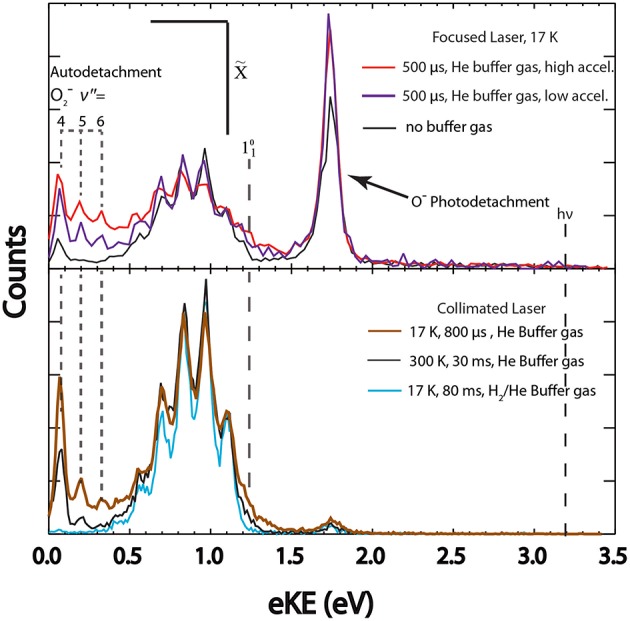
The total photoelectron spectrum for O3- with different temperatures, trap times, and laser configurations is shown. Top panel (high laser fluence): Spectra collected with short trapping times (500 μs) with higher (red trace) and lower (purple trace) entrance lens acceleration compared to no buffer gas (black trace). Bottom panel (low laser fluence): Short trapping time at cold temperatures (800 μs, 17 K, neat He buffer gas) shown in brown, longer trapping times at room temperature (30 ms, 300 K, neat He buffer gas) shown in black, long trapping times at cold temperatures (80 ms, 17 K, H2/He buffer gas) shown in blue.